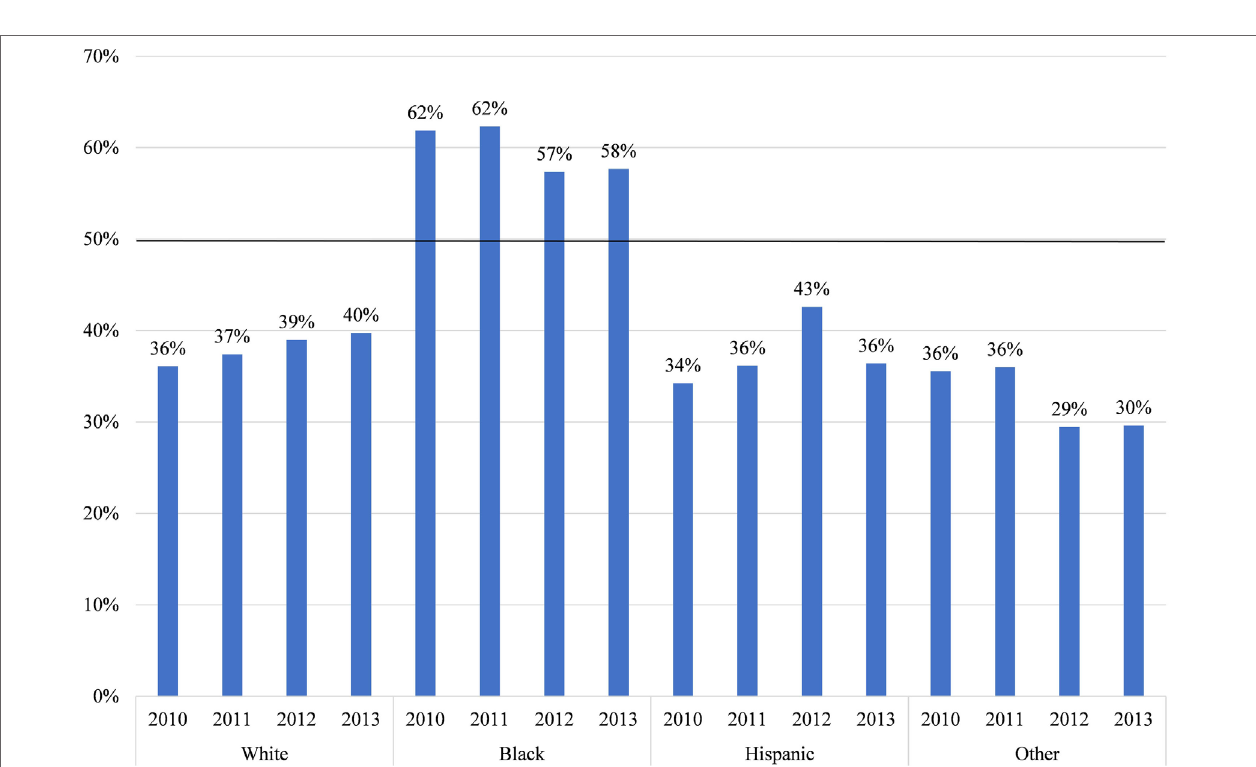
FigUre 5 | Median rate of dentists per 100,000 of population in county, by race, in Maryland 2010–2013.